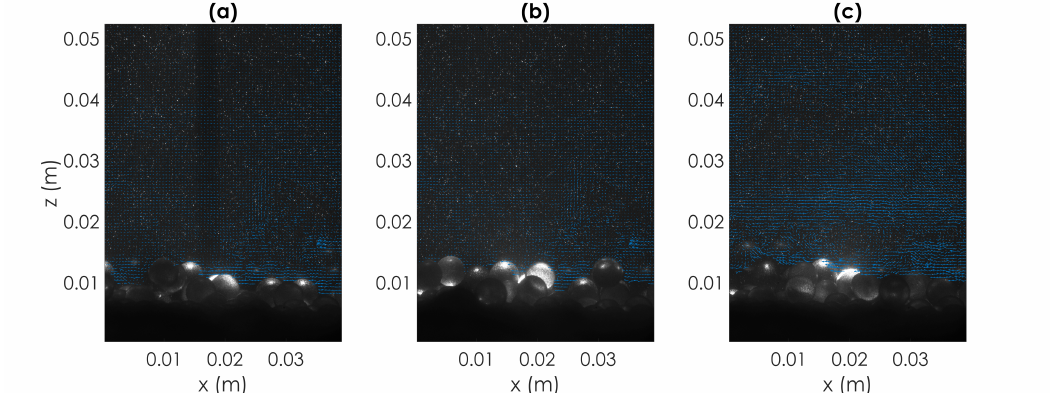
Figure 18. Particle entrained because of collective entrainment (Type D , particle 4, Test T2). Sequence of three PIV images respectively showing (from ( a – c )): at time t = t 0 (2 time instants, corresponding to 0.1333 s, before entrainment) the bright particle located in the centre of the image is at rest in the bed (partially hidden by another particle); at time t = t 0 + ∆ t (1 time instant, corresponding to 0.067 s, before entrainment) the particle is still at rest in the bed and travelling particles are about to collide with sediments in the bed; at time t = t 0 + 2 ∆ t several particles, included the bright one, are mobilized because of the impact. (For clarity only 1 out of 2 vectors are depicted.)